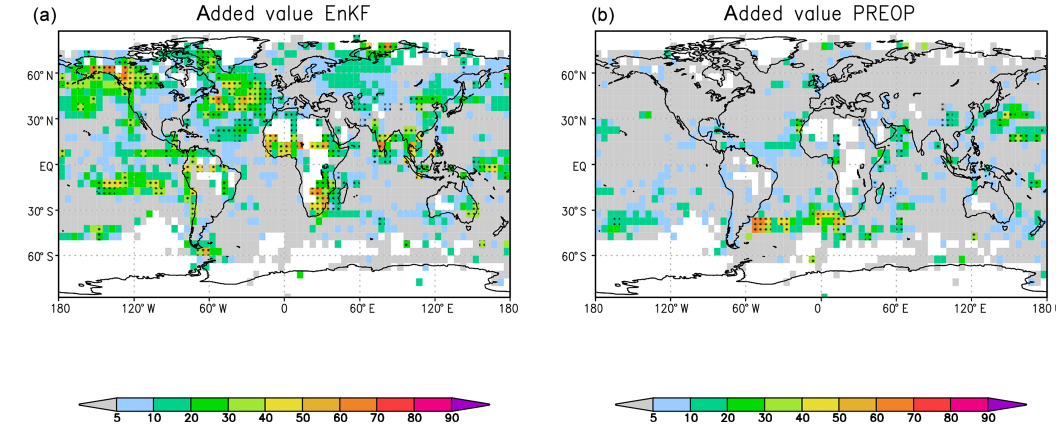
Figure 2. As in Fig. 1 but for added values from partial correlations between HadCRUT4 and EnKF, given PREOP, (a) and between HadCRUT4 and PREOP, given EnKF (b) . Black dots indicate where the partial correlations are above the 5% significance